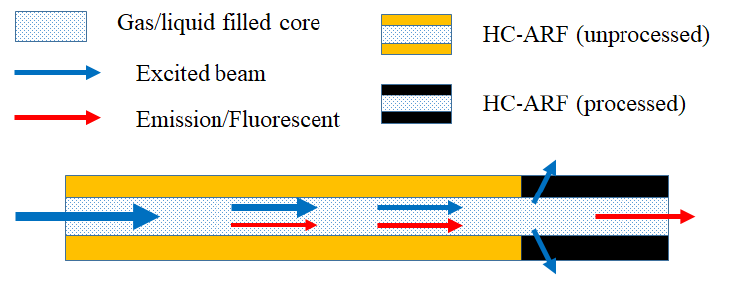
Figure 8. This schematic diagram shows the working principle of the HC-ARF-based filter in gas-/liquid-filled optical